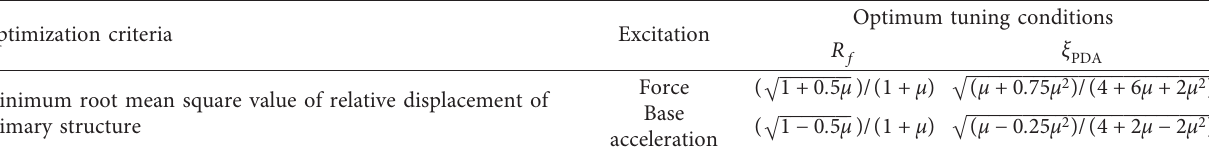
Table 3: Optimum tuning conditions for PTMDs attached to an undamped primary